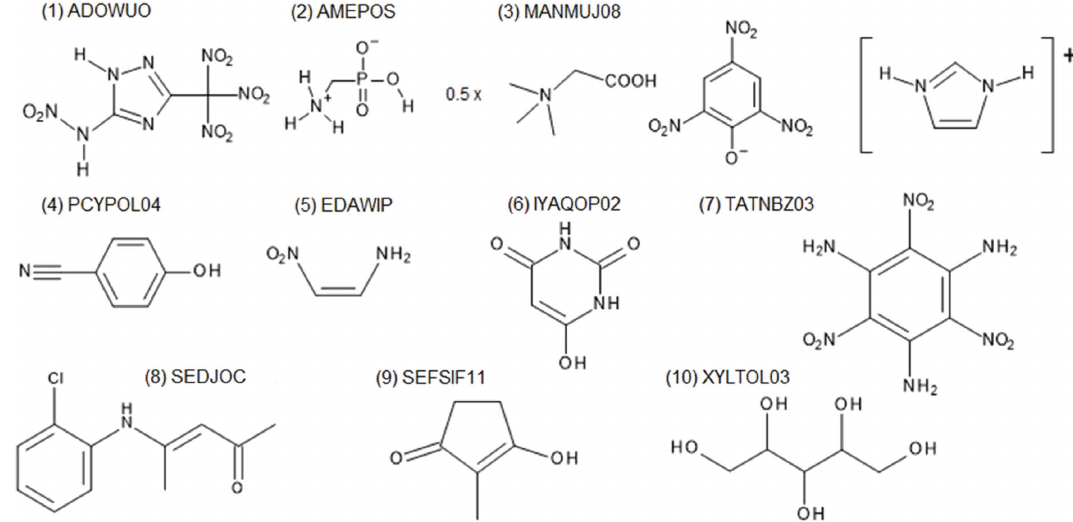
Figure 3 Structures used for testing the influence of the basis set on the X —H bond